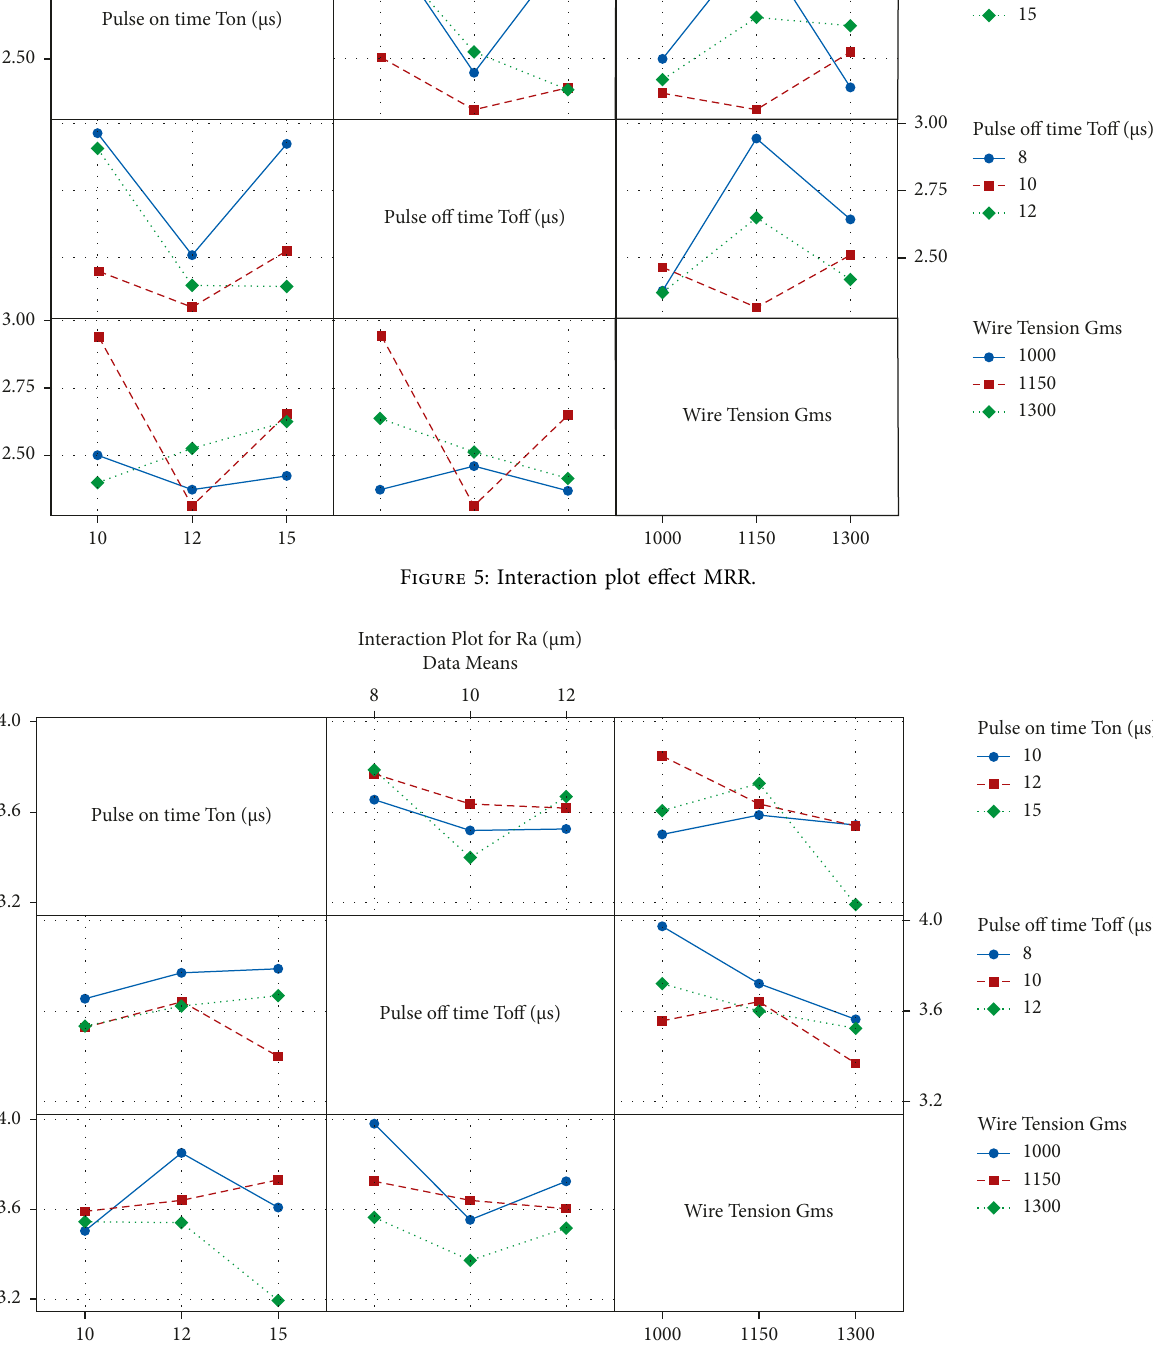
Figure 6: Interaction plot effect